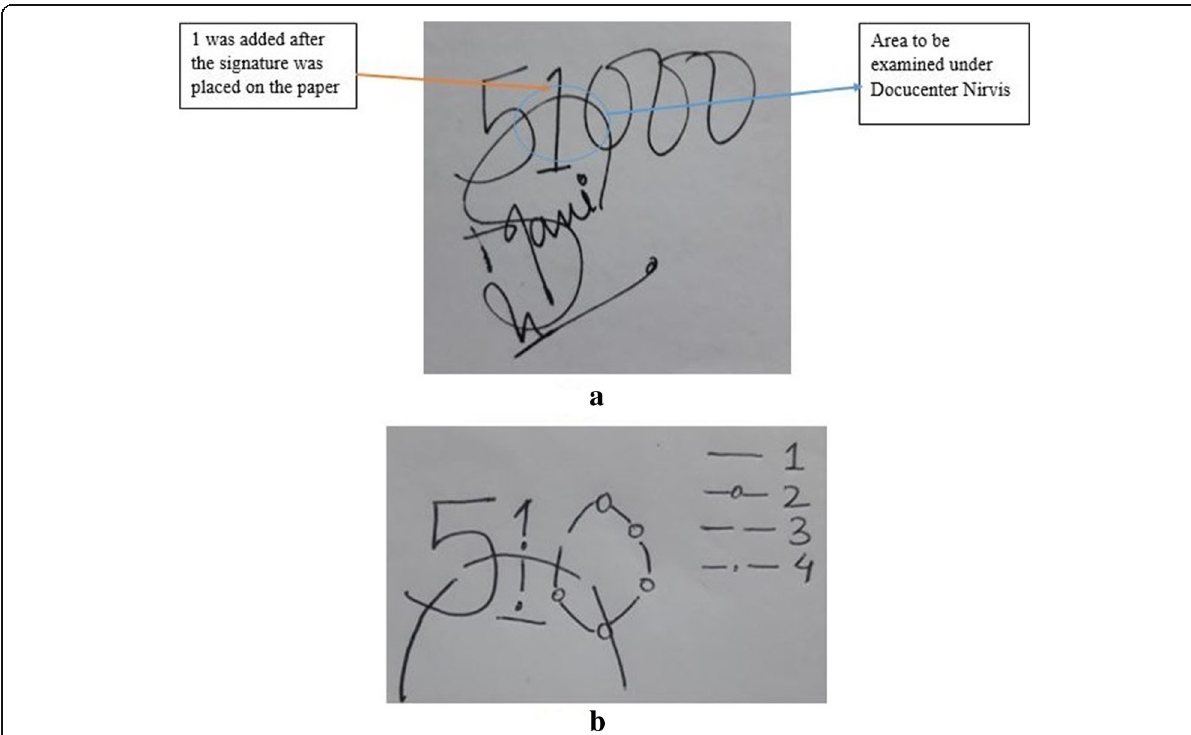
Fig. 4 a Image of the model sample. b Image of the sequence